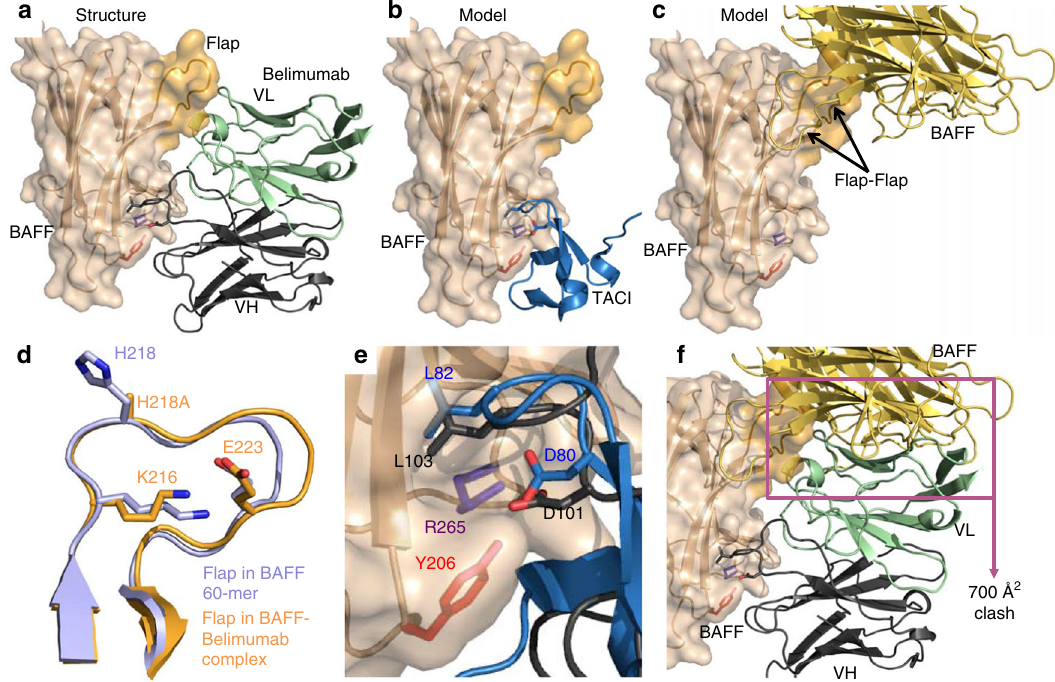
Fig. 8 Prominent features of the BAFF 3-mer – belimumab Fab complex. The structure of BAFF H218A (3-mer) in complex with the Fab of belimumab was solved. The experiment was performed once. A model of the cysteine-rich domain 2 of TACI bound to BAFF was obtained by superposing the structure of one BAFF monomer to the structure of APRIL in the APRIL – TACI complex (PBD-ID 1XU1). a Structure of one BAFF monomer (pale yellow) to one belimumab Fab (heavy chain in black, light chain in green). The fl ap of BAFF is shown in darker yellow. b Model of TACI bound to BAFF. c Model showing the position of the adjacent BAFF monomer if a fl ap – fl ap interaction would have occurred. The model was built by superimposing two relevant BAFF monomers from the BAFF 60-mer structure (PDB-ID 1OQE) to one BAFF monomer of the BAFF – belimumab Fab complex. d Superimposition of the fl ap of a BAFF from the BAFF 60-mer structure (pale purple) (PDB-ID 1OQE) and a fl ap from the BAFF H218A – belimumab Fab complex (orange). Residues K216 and E223 that make important contacts with E223 and K216 of an adjacent fl ap in the BAFF 60-mer structure are shown. e Detail of the receptor-binding pocket of BAFF, showing interaction with the DXL motif of belimumab (D101, L103). The DXL motif of TACI (D80, L82) (PDB-ID 1XU1) is superimposed. Y206 and R265 of BAFF are also shown. f The structure of the BAFF – Fab complex of panel a was merged to that of the fl ap-mediated BAFF – BAFF interaction of panel c . The large clash area between both structures suggests that belimumab cannot access its binding site in BAFF